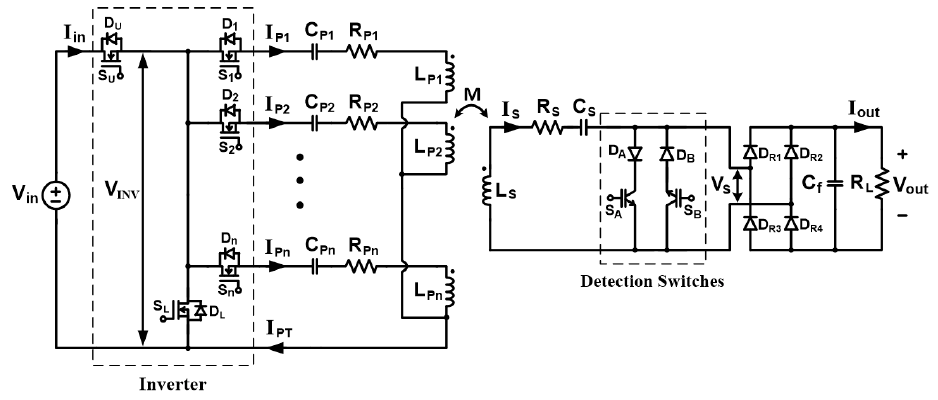
Figure 2. Circuit configuration of the proposed system.